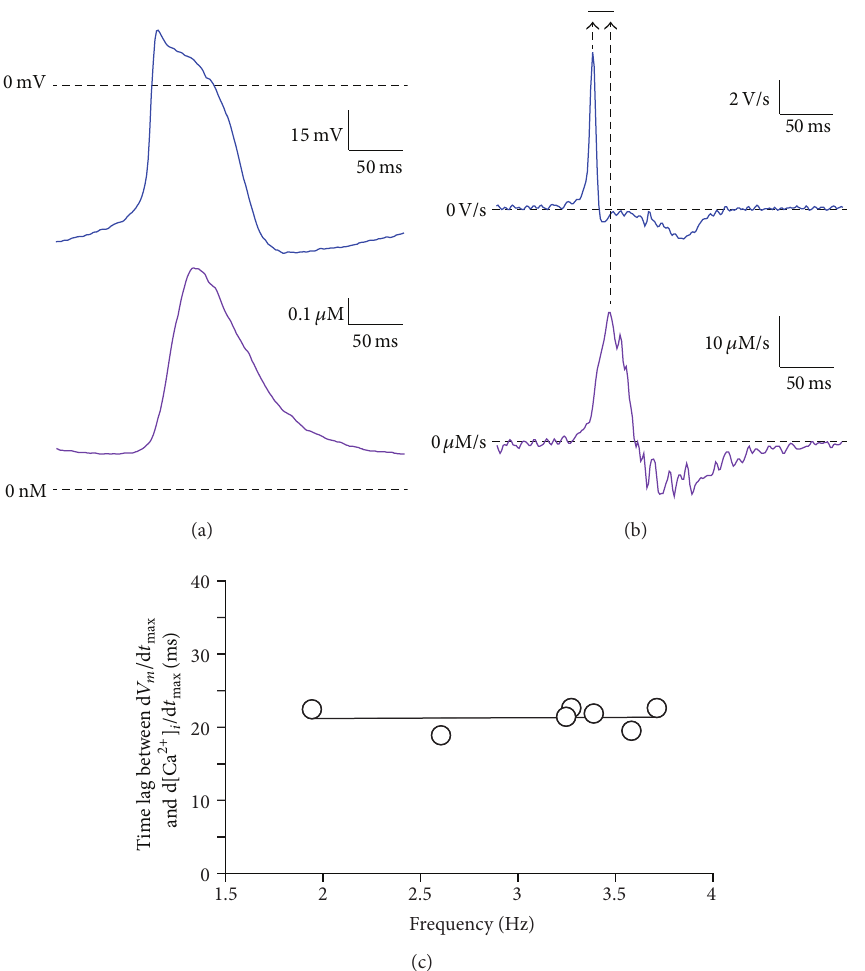
Figure 2: (a), Simultaneously recorded action potential (top) and [ Ca 2+ ] 𝑖 transient (bottom) of a rabbit SAN cell. (b) Time derivatives of the action potential (top) and [ Ca 2+ ] 𝑖 transient (bottom) traces shown in panel (a). Arrows indicate the timing of the maximum rate of change in membrane potential (d 𝑉 𝑚 / d 𝑡 max ) and intracellular Ca 2+ concentration (d [ Ca 2+ ] 𝑖 / d 𝑡 max ). Horizontal bar indicates the time lag of ≈20 ms. (c) Time lag between the occurrence of d 𝑉 𝑚 / d 𝑡 max and d [ Ca 2+ ] 𝑖 / d 𝑡 max versus beating frequency of the 7 cells measured. Solid line is the linear regression line (slope 0.1 ± 1.1; 𝑅 = 0.042 ). Note the absence of an appreciable frequency dependence of the time